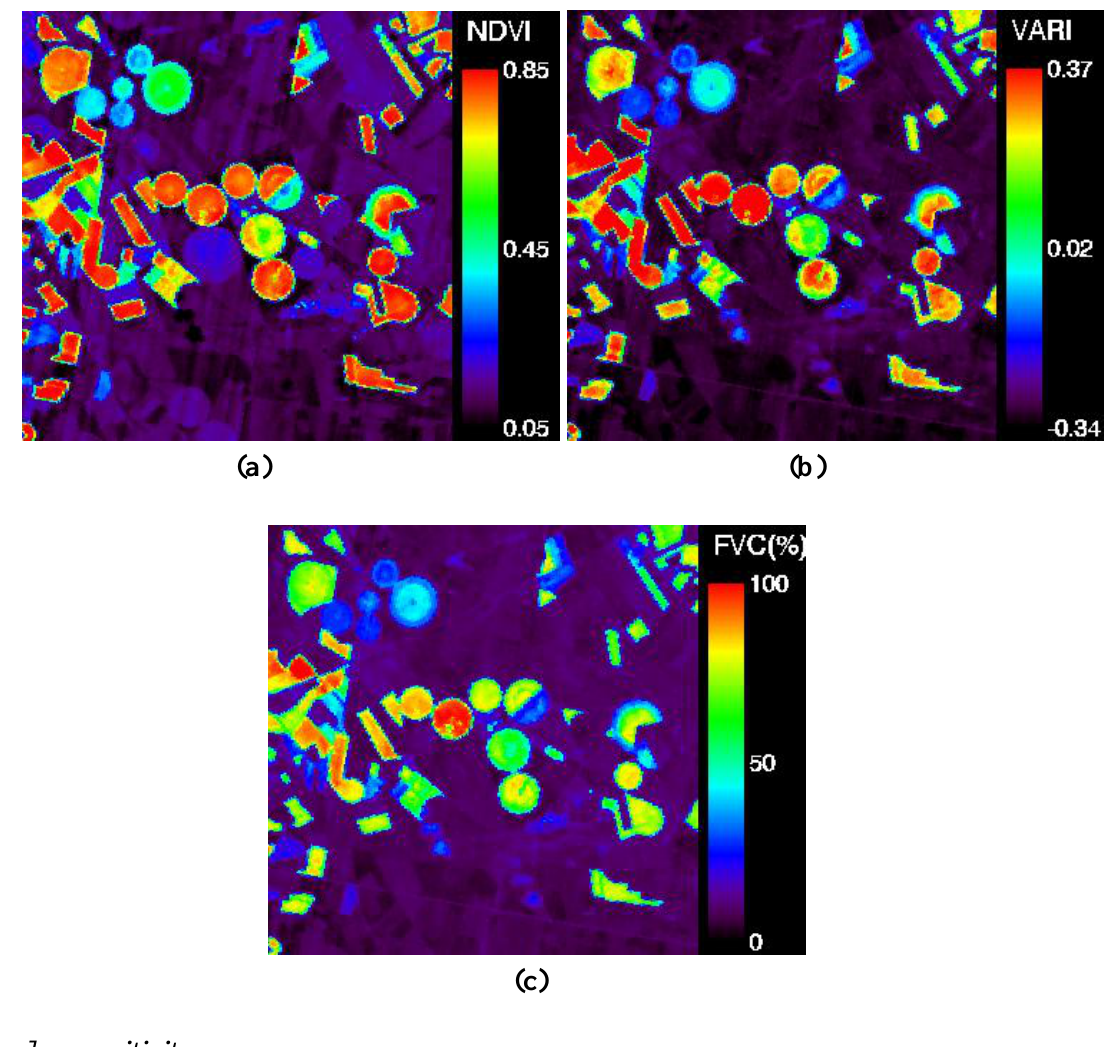
Figure 9. (a) Normalized Difference Vegetation Index (NDVI), (b) Variable Atmospherically Resistant Index (VARI) and (c) Fractional Vegetation Cover (FVC) retrieved from VARIgreen. Maps obtained from PROBA/CHRIS image acquired at near nadir view (see Figure